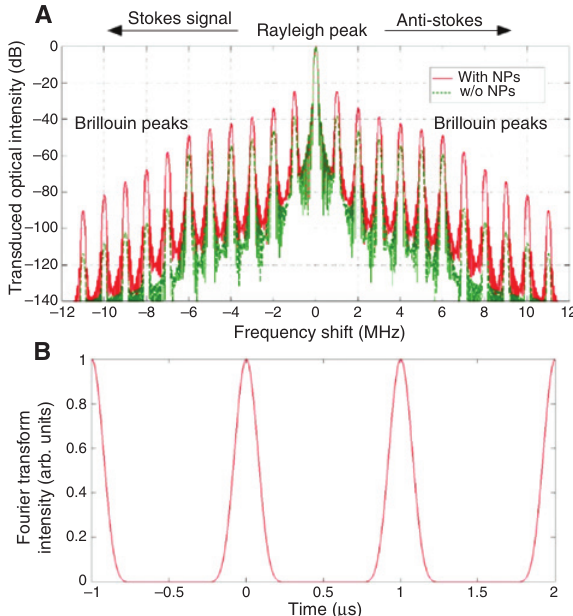
Figure 4: Optical frequency comb generated from nonlinear ultrasound. (A) Optical frequency comb generated from nonlinear ultrasound propagating in bulk water (theory). In this particular example, the spacing between the comb peaks equals 1 MHz, which is set by the frequency of the incident sound. Note an enhancement (red solid curve) in the peak intensity due to plasmon nanoparticles (NPs) acting as optical antennas with respect to bulk water without nanoparticles (green dashed curve). (B) Fourier transform of the spectrum in (A). Adapted with permission from [122]. Copyright 2016, Optical Society of